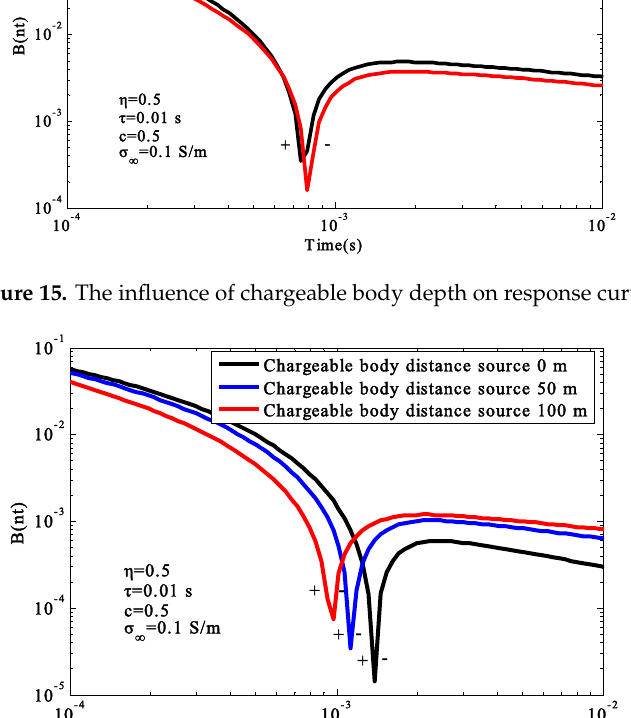
Figure 16. The influence of different emitter locations on IP effect.